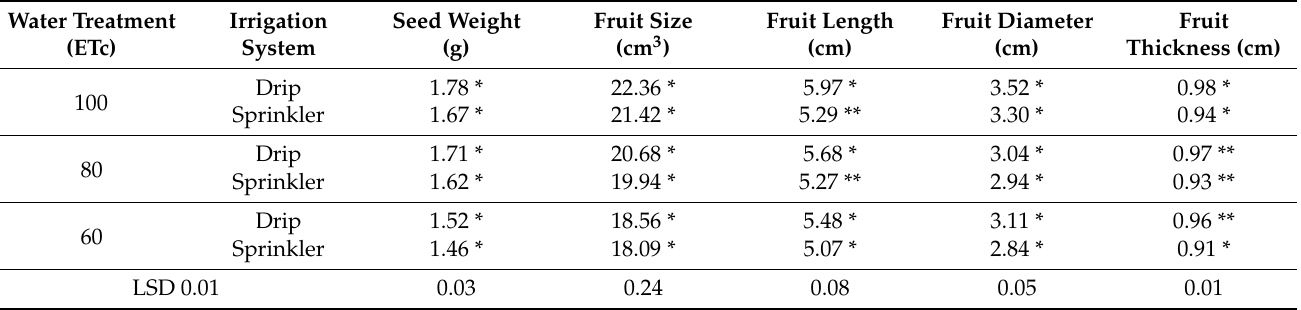
Table 5. Effect of different irrigation and water treatments on seed weight, fruit size, fruit length, diameter and thickness of date palm.